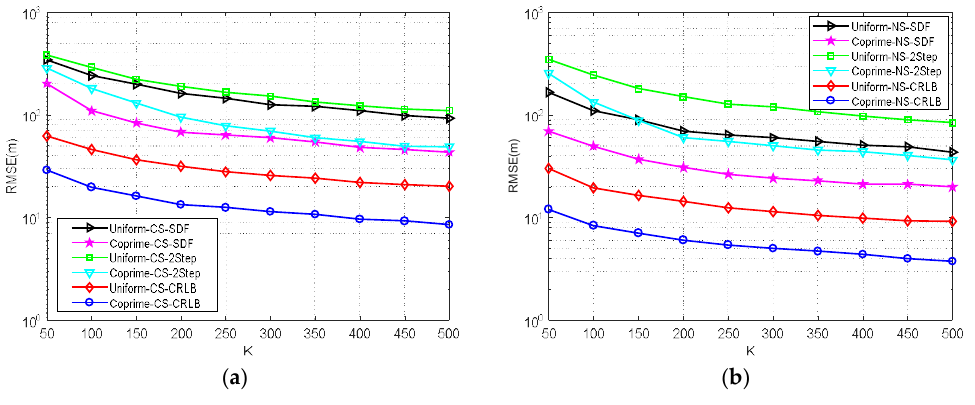
Figure 10. Estimation performance of different snapshots ( a ) CS ( b ) NS.